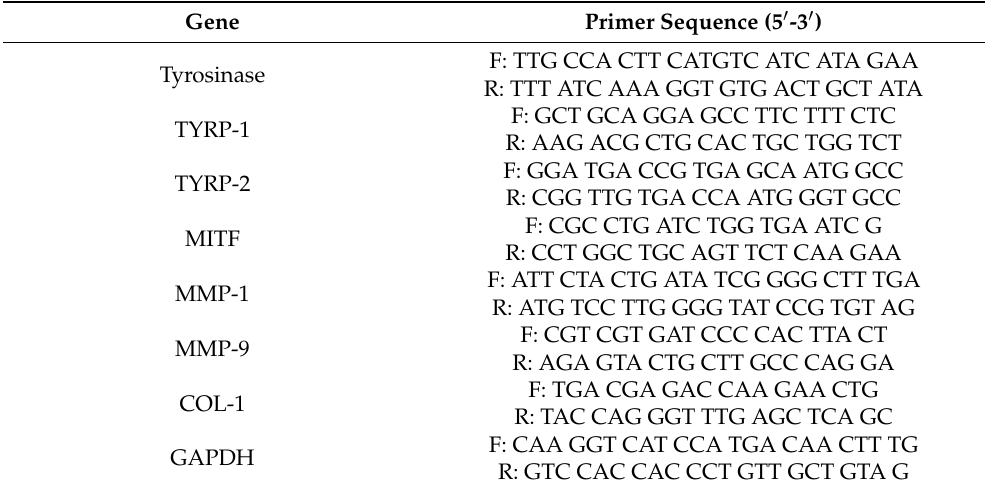
Table 2. Sequences of primers used for mRNA gene expression analysis by qRT-PCR. Gene Primer Sequence (5 (cid:48) -3 (cid:48)